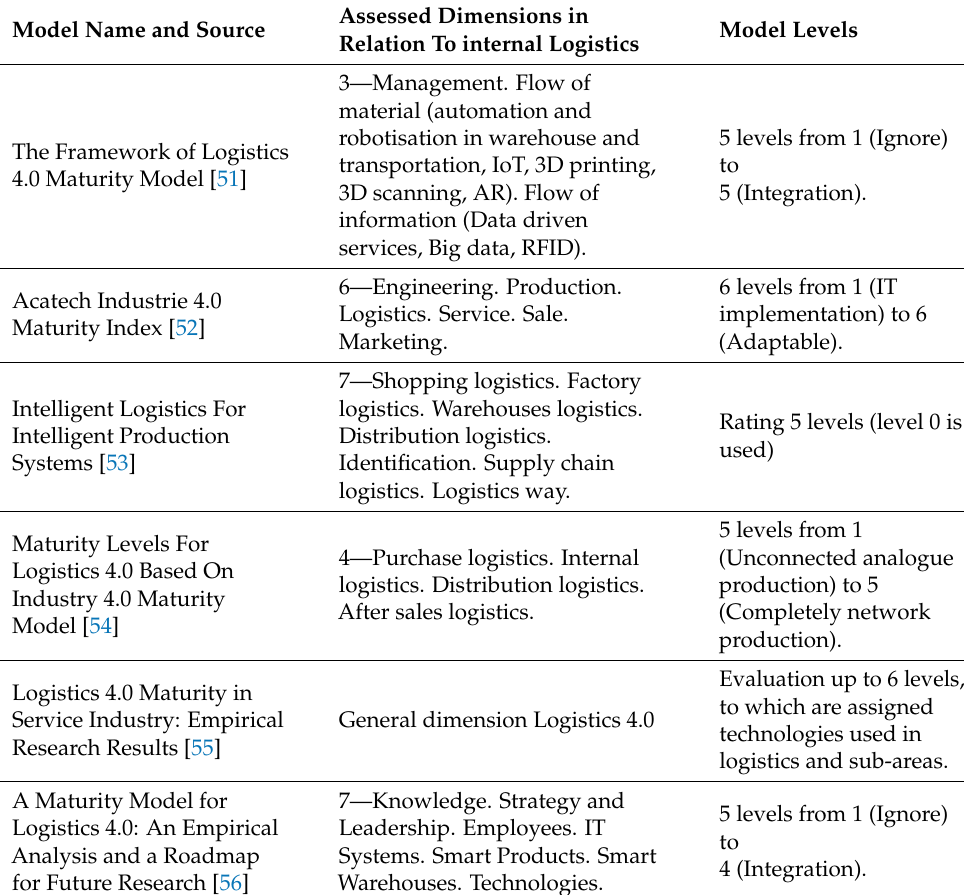
Table 3. Readiness models with assessment of internal